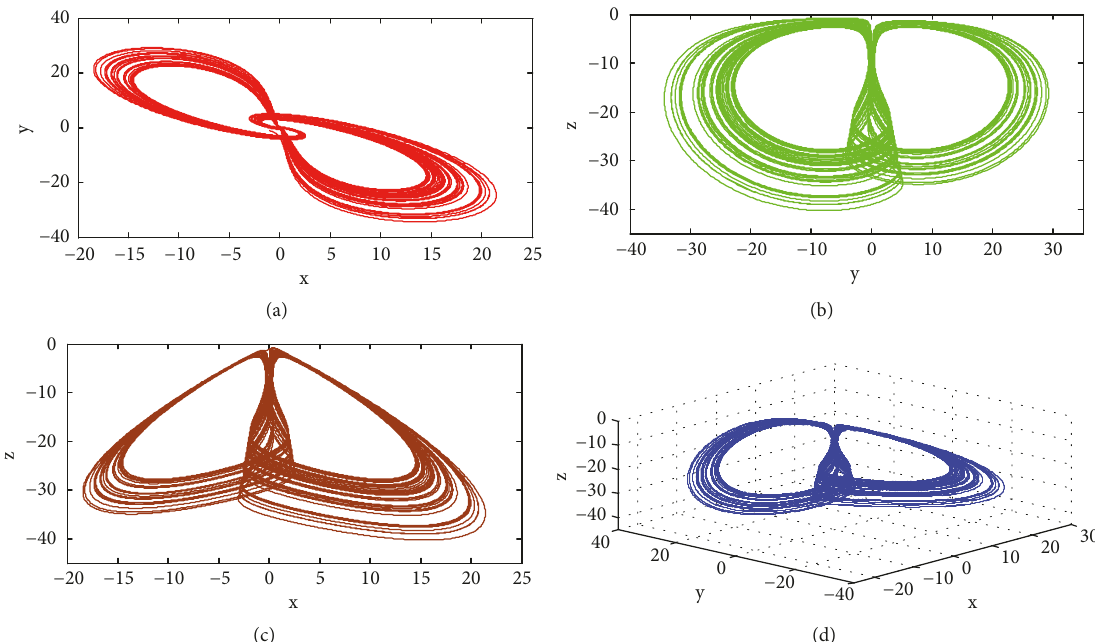
Figure 1: Attractor for Xian system: (a) 𝑥 − 𝑦 phase plane, (b) 𝑦 − 𝑧 phase plane, (c) 𝑥 − 𝑧 phase plane, and (d) phase space.